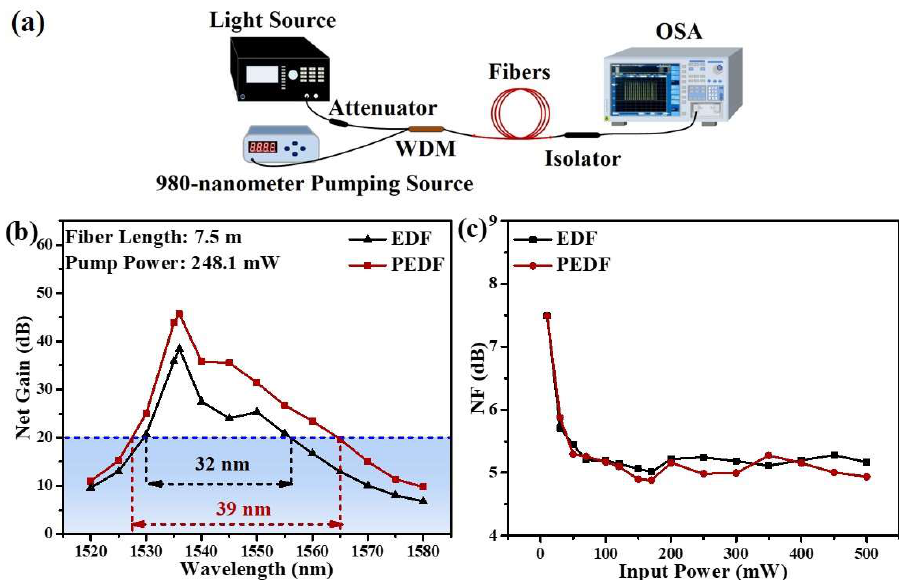
Figure 11. ( a ) Schematics of the 1.5-micrometer band fiber amplifier; ( b ) gain characteristics for two fibers; ( c ) the variation of NF with the different input powers for EDF and PEDF.